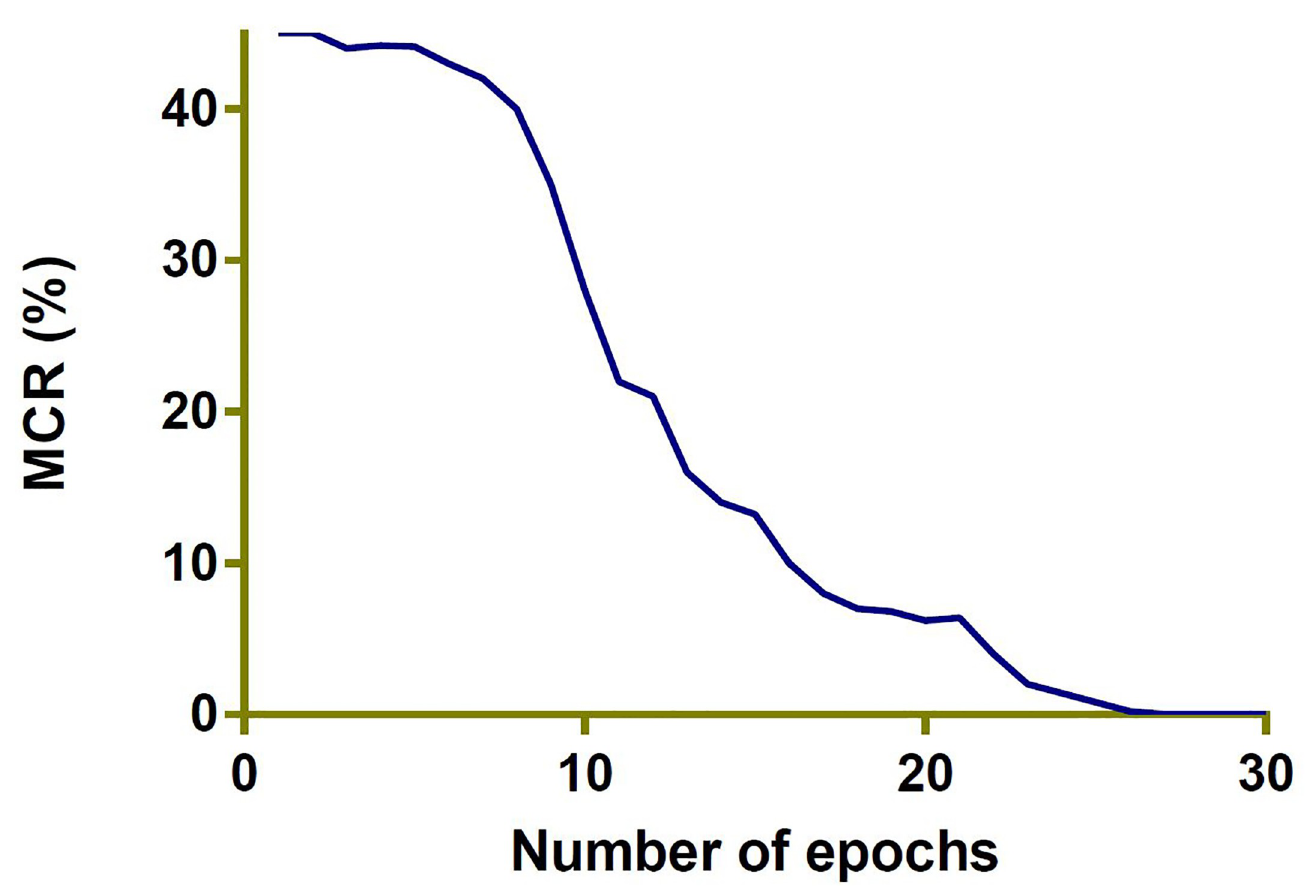
Fig 6. MCR (%) for training